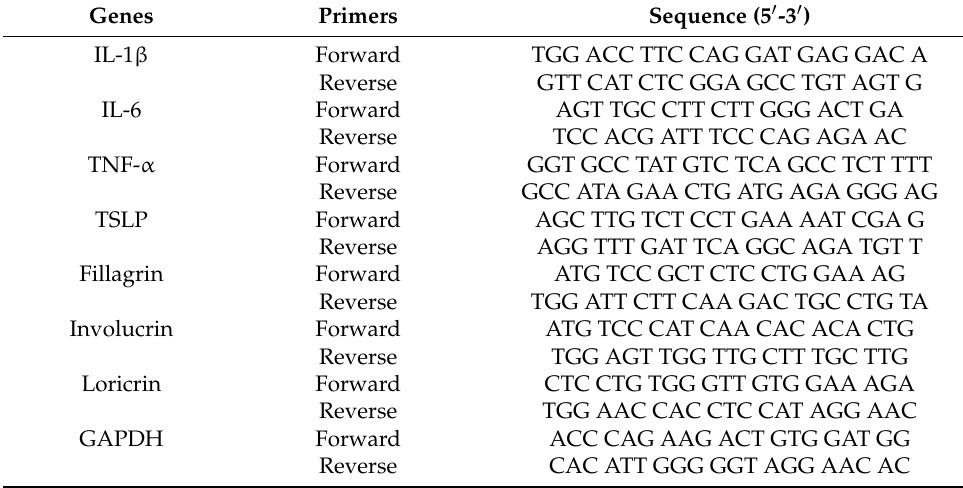
Table 2. Mouse primer sequences for